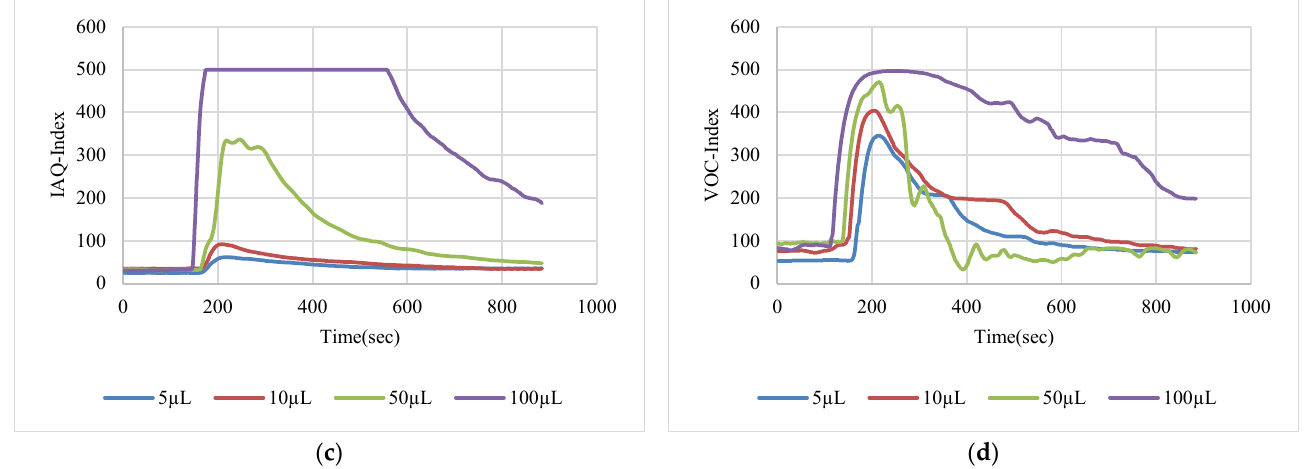
Figure 19. Test results for methanol: ( a ) BME688 40 cm, ( b ) SGP41 40 cm, ( c ) BME688 100 cm, ( d ) SGP41 100 cm.